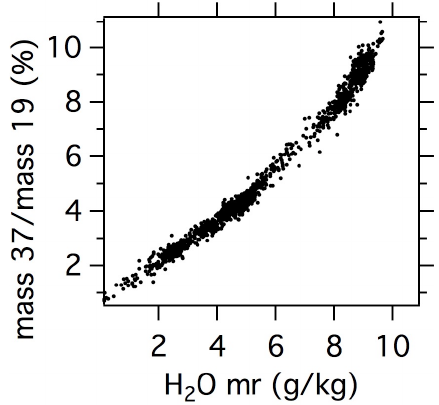
Fig. 4. The ratio of H 3 OH 2 O + /H 3 O + (mass37/mass19) versus the ambient water mixing ratio (i.e. humidity) for a typical flight during CalNex Figure 4: The ratio of H mixing ratio (i.e. humidity) for a typical flight during CalNex 2010.